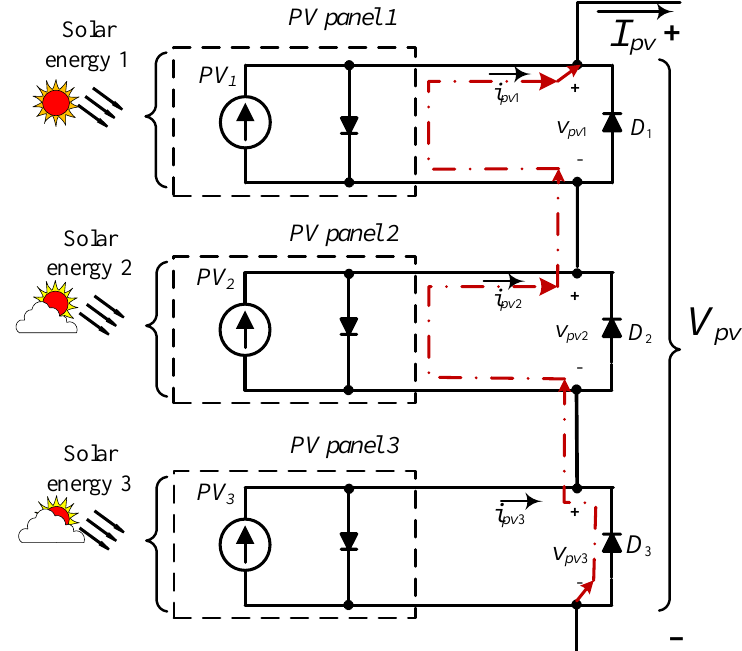
Figure 3. Model of the PV string under partial shading conditions. Table 2. Relationship between the output voltage and current under partial influences.